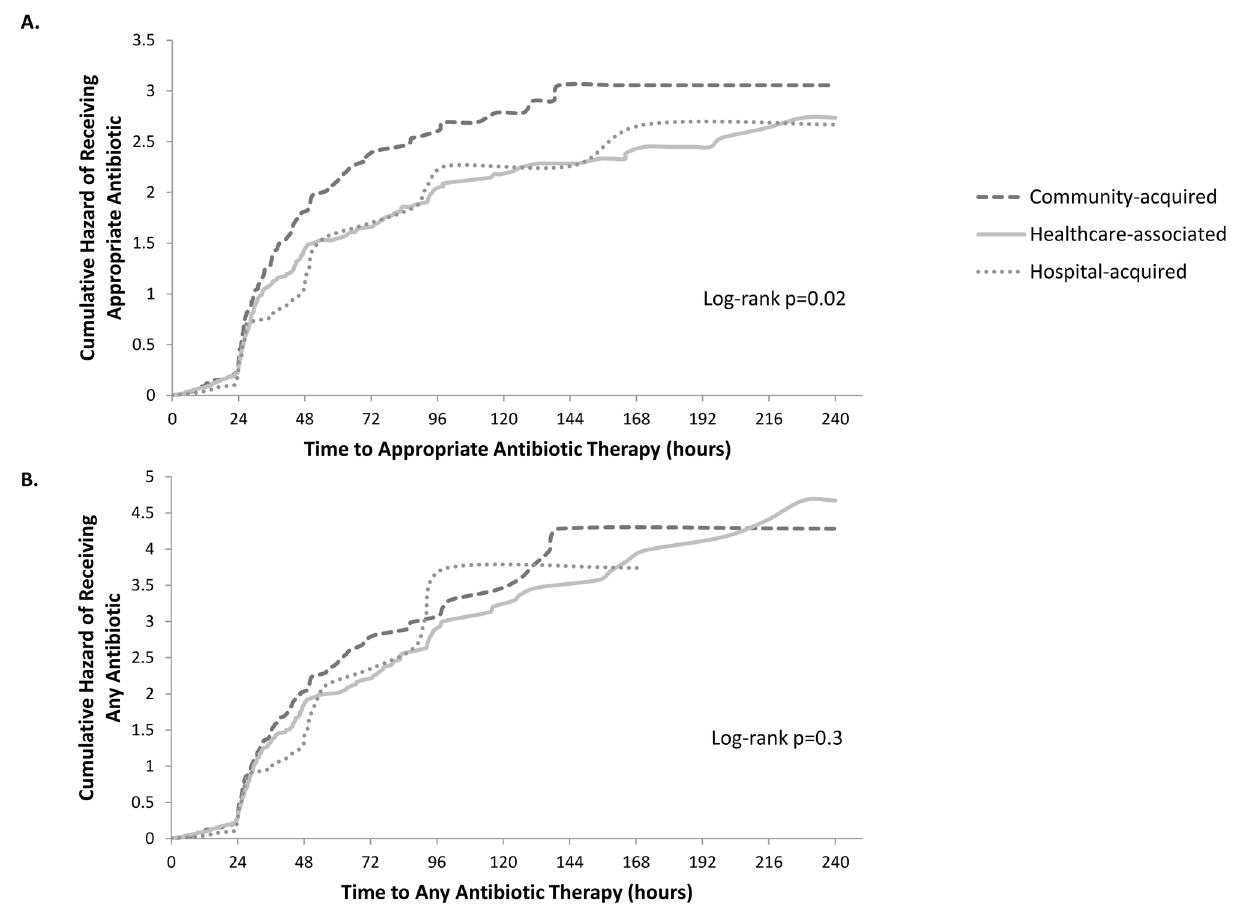
Figure 1. Cumulative hazard of receiving appropriate antibiotic therapy or any antibiotic therapy based on Kaplan-Meier analysis. Cumulative hazards among healthcare exposure categories of patients with Gram-negative bloodstream infections in community hospitals, 2003-2006. Healthcare exposure categories include community-acquired (dashed dark-gray line), healthcare- associated (solid light-gray line), and hospital-acquired (dotted light-gray line). For all analyses, the origin of the risk period was defined as starting 24 hours prior to blood culture